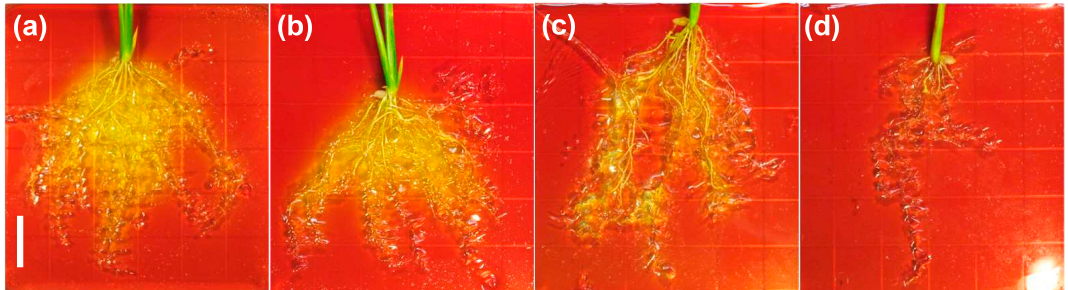
Figure 5. O/E plants show a decrease in the activity of H + -pump ATPases of the plasma membrane in response to salt stress. 10-day-old seedlings were treated with or without 50 mM NaCl for 7days. Then plants were transferred onto the 0.75% agar medium supplemented with 1 mM CaSO 4 , 2.5 mM K 2 SO 4 , and 0.006% bromocresol purple gently imbedding the roots on the surface of the medium. All agar plates were placed in a growth chamber under light for 6 h. Note that yellowing of the test plate represents acidification. Pictures were taken afterwards. 4–5 plants were used per condition and representative results were shown: ( a ) sibling WT plants without stress; ( b ) O/E plants without stress; ( c ) sibling WT plants with salt stress; and, ( d ) O/E plants with salt stress. Note that a white bar represents 1.5 cm.